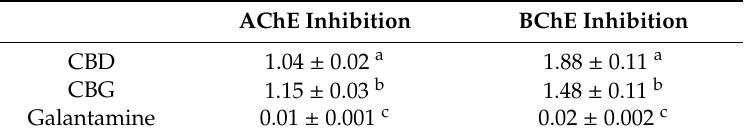
Table 1. Anti-cholinesterase activity.